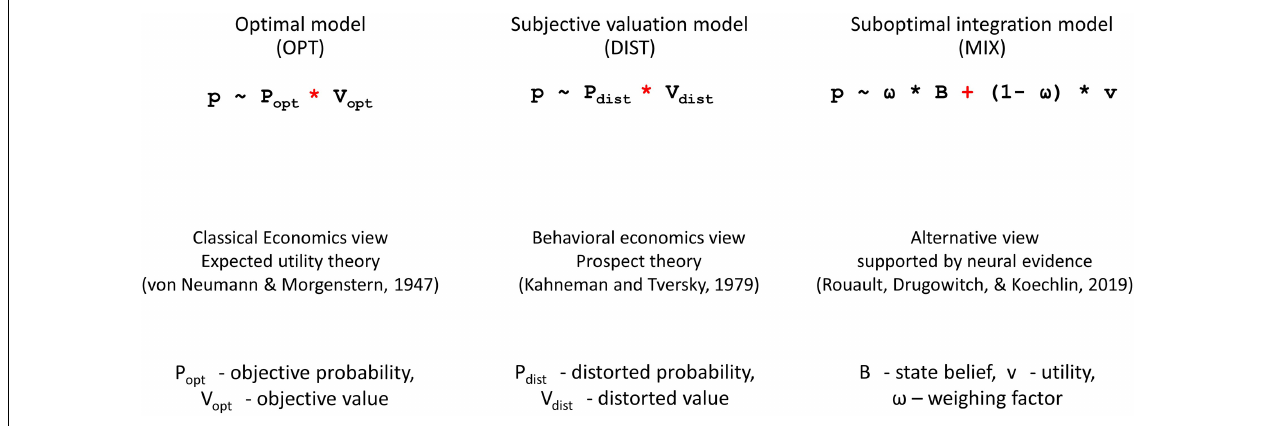
FIGURE 1 | Probability of choosing an option according to classical economics view (the leftmost panel) , behavioral economics view (the middle panel) , and a recently developed MIX model (the rightmost panel)